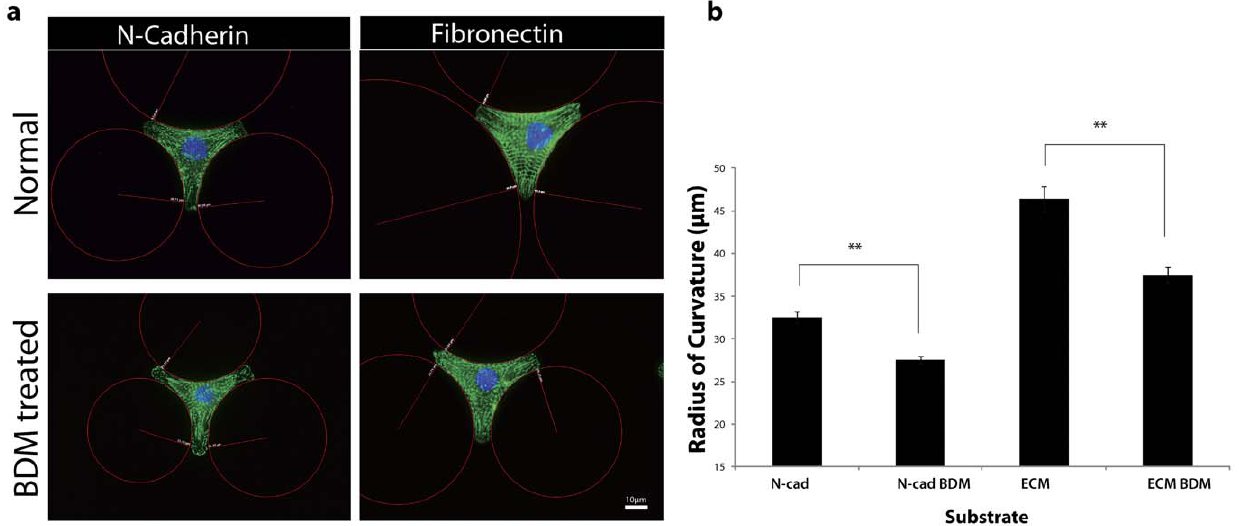
Figure 3. Radius of curvature is a function of contractility (a) Representative images of radius of curvature with and without BDM (b) Quantitative assessment shows that the radius of curvature decreases with myosin inhibition in myocytes on both N-cad and Fn substrates. **p , 0.01, error bars 6 1 SEM for 40 cells.